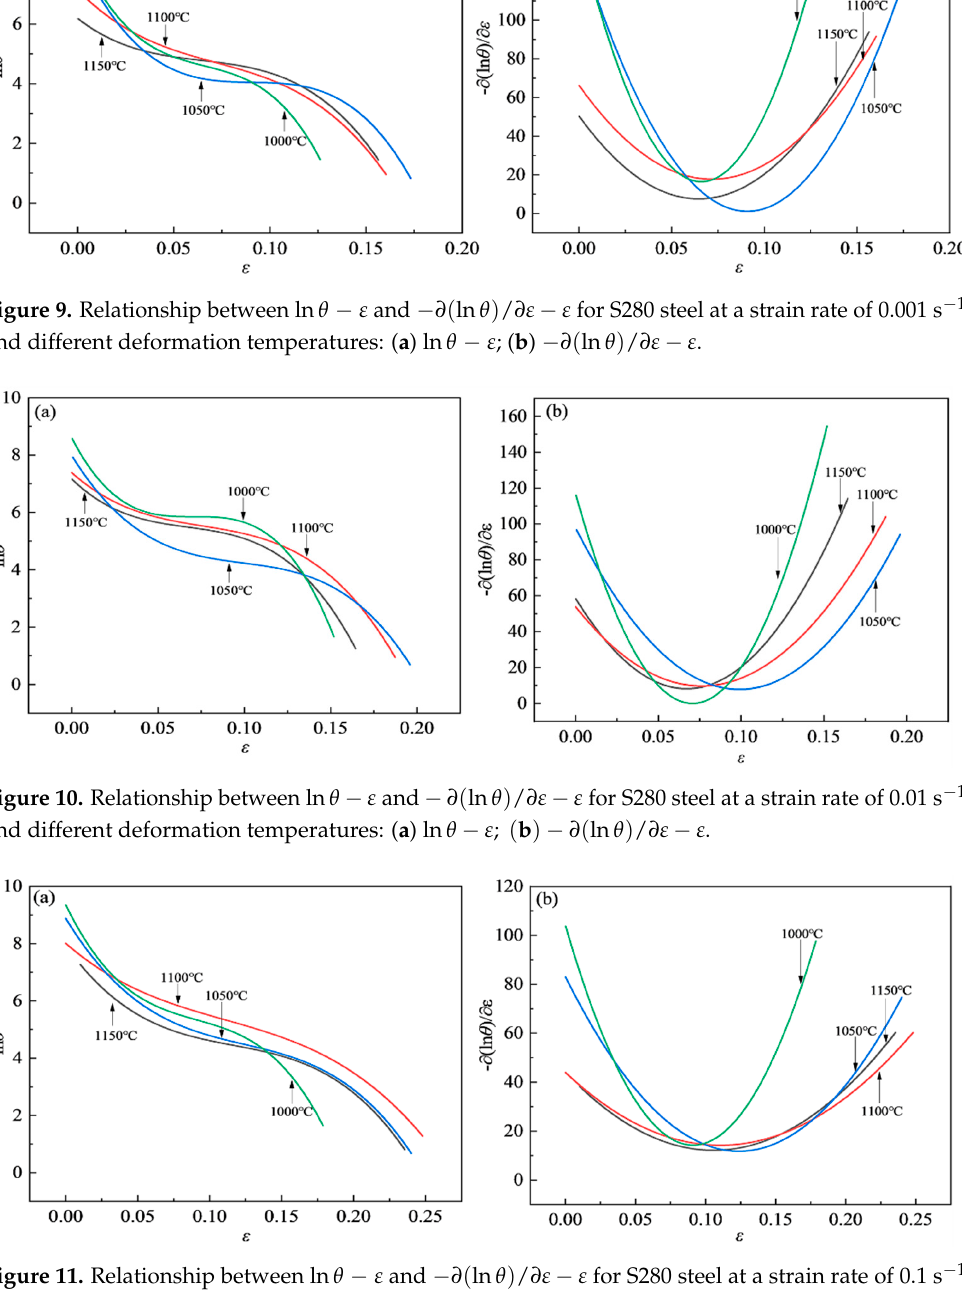
Figure 11. Relationship between ln θ − ε and − ∂ ( ln θ ) / ∂ε − ε for S280 steel at a strain rate of 0.1 s − 1 Figure 11. Relationship between ln𝜃 – 𝜀 and − ∂(ln𝜃)/ ∂𝜀 − 𝜀 for S280 steel at a strain rate of 0.1 Figure 11. Relationship between ln𝜃 – 𝜀 and − ∂(ln𝜃)/ ∂𝜀 − 𝜀 for S280 steel at a strain rate of 0.1 Figure 11. Relationship between ln𝜃 – 𝜀 and − ∂(ln𝜃)/ ∂𝜀 − 𝜀 for S280 steel at a strain rate of 0.1 s − 1 and different deformation temperatures: ( a ) ln𝜃 − 𝜀 ; ( b ) − ∂(ln𝜃)/ ∂𝜀 − 𝜀 . and different deformation temperatures: ( a ) ln θ − ε ; ( b ) − ∂ ( ln θ ) / ∂ε − ε s − 1 and different deformation temperatures: ( a ) ln𝜃 − 𝜀 ; ( b ) − ∂(ln𝜃)/ ∂𝜀 − 𝜀 . s − 1 and different deformation temperatures: ( a ) ln𝜃 − 𝜀 ; ( b ) − ∂(ln𝜃)/ ∂𝜀 − 𝜀 .